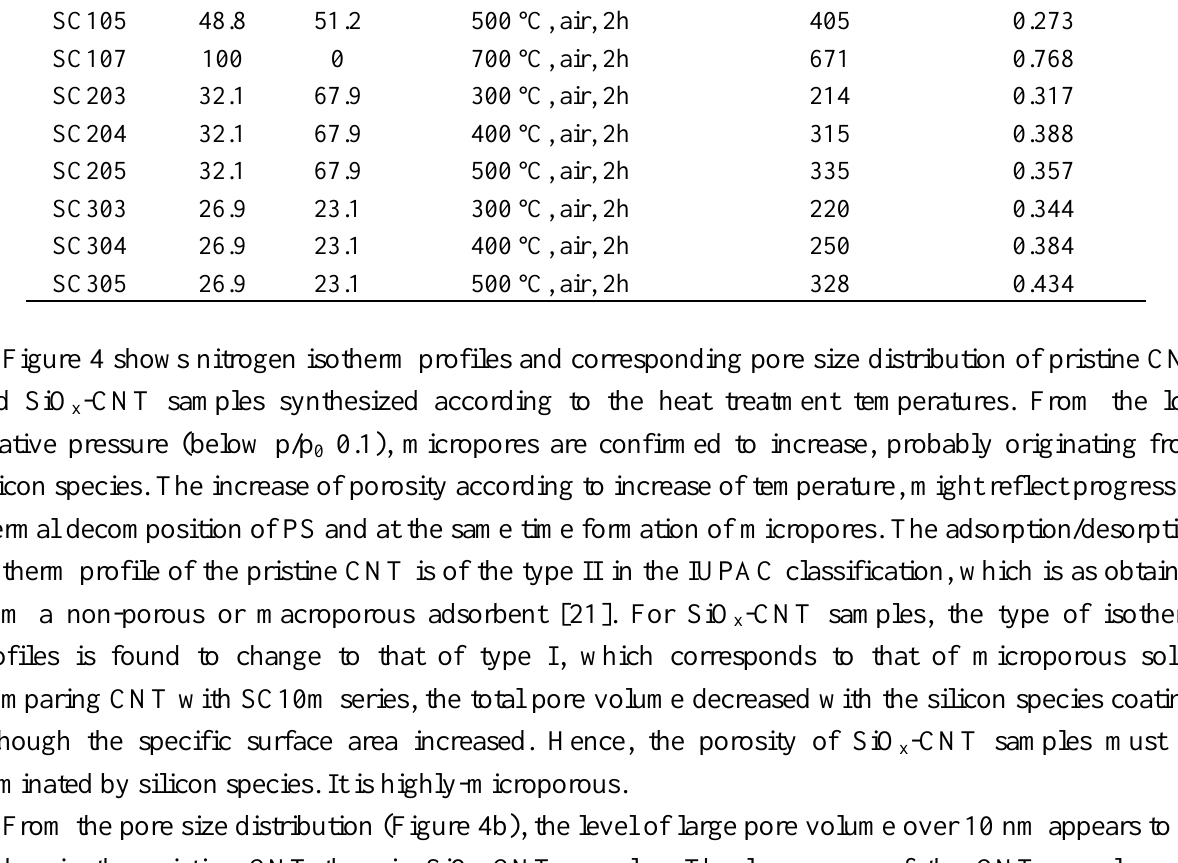
Table 1. Surface properties and the contents of SiO